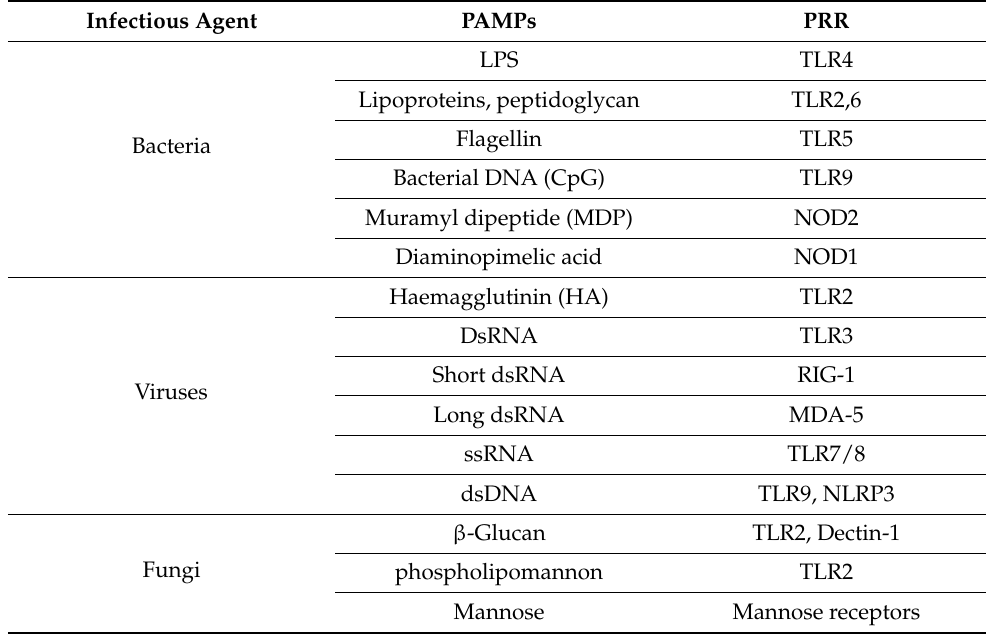
Table 1. Infectious agents-derived PAMPs and their